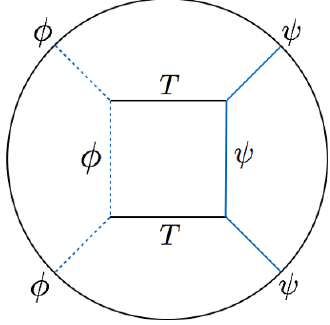
Figure 4 . A universal AdS loop diagram for theories with gravity. We label AdS (cid:12)elds by their dual CFT